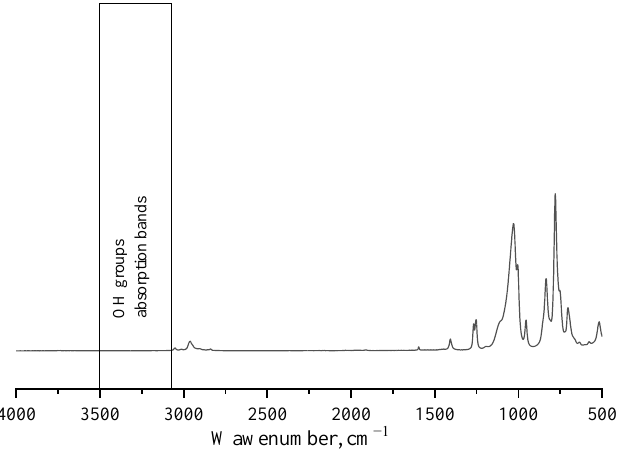
Figure 3. IR spectrum of blocked Sample 5 (Table 1).